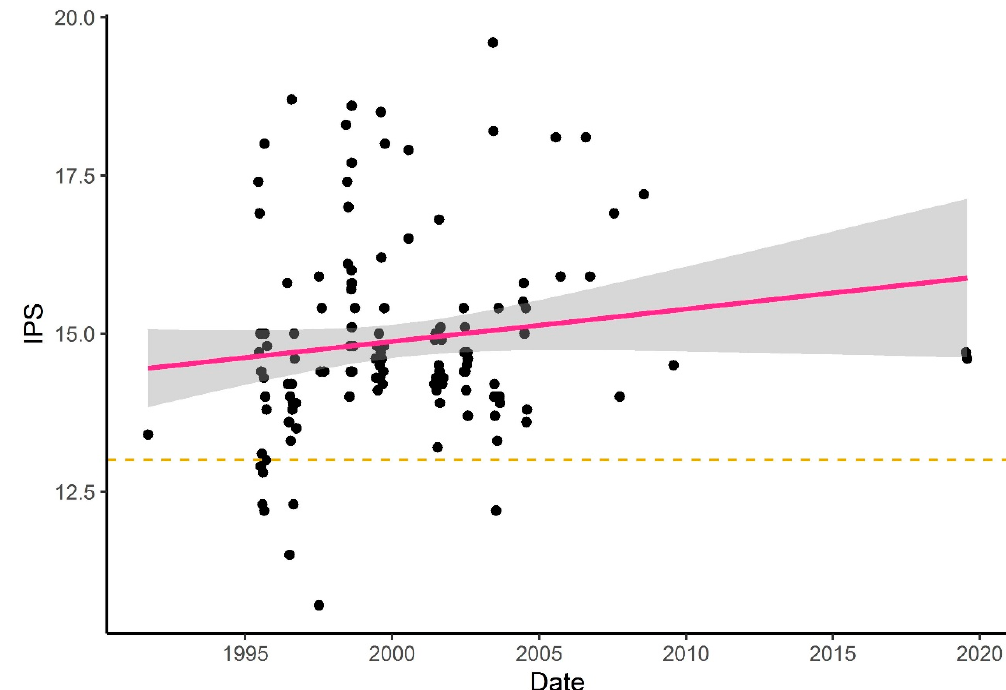
Figure 9. Values of the qualifying index are based on the composition of epiphytic diatom assemblages of deployed and natural reeds at c5 and c6 sites of the Cikola tributary system. Confidence intervals of the linear trend line is fitted to the points (R 2 = 0.02, p = 0.120). Orange dashed line indicates good/moderate boundary of the index.